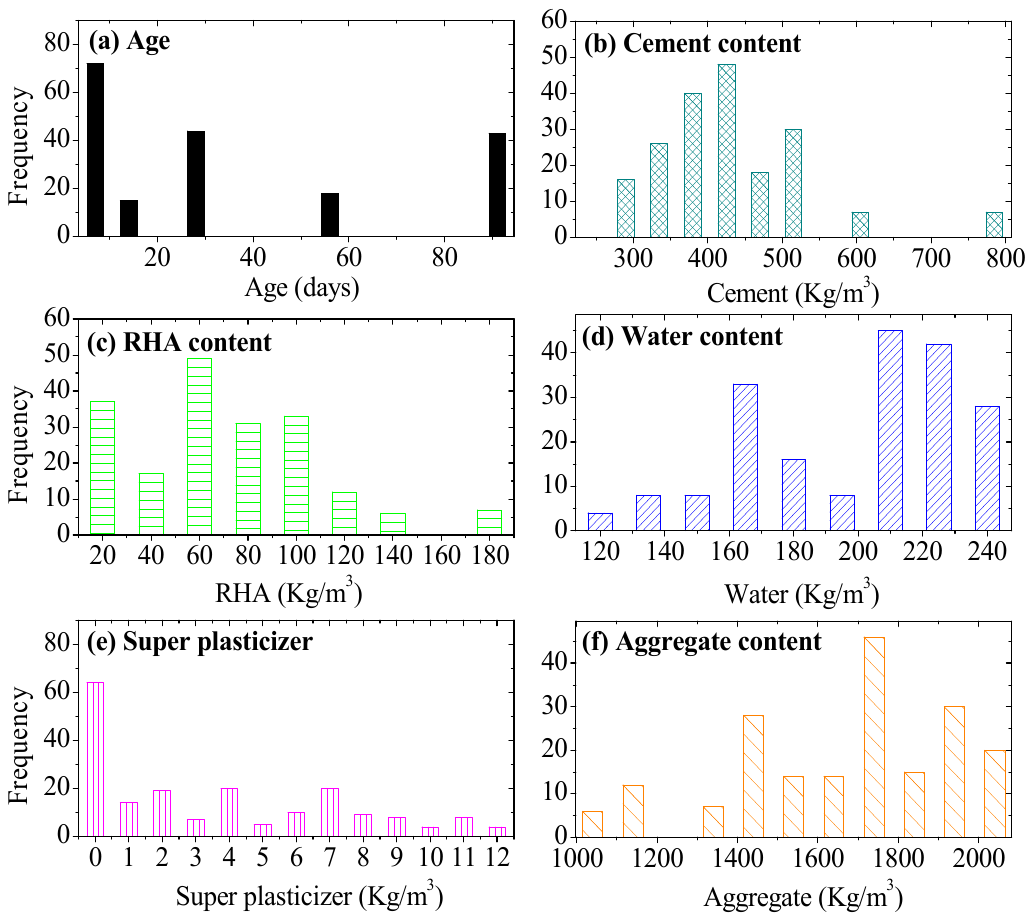
Figure 3. Frequency distribution histograms for: ( a ) age, ( b ) cement content, ( c ) RHA content, ( d ) water content, ( e ) superplasticizer, and ( f ) aggregate content.